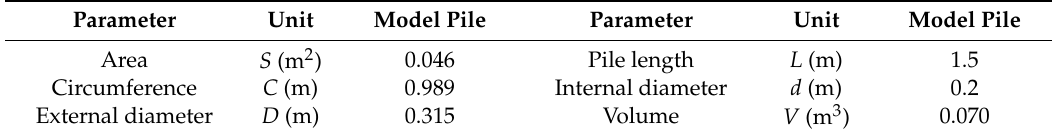
Table 1. Parameters of the cast-in-place large-diameter (PCC) model